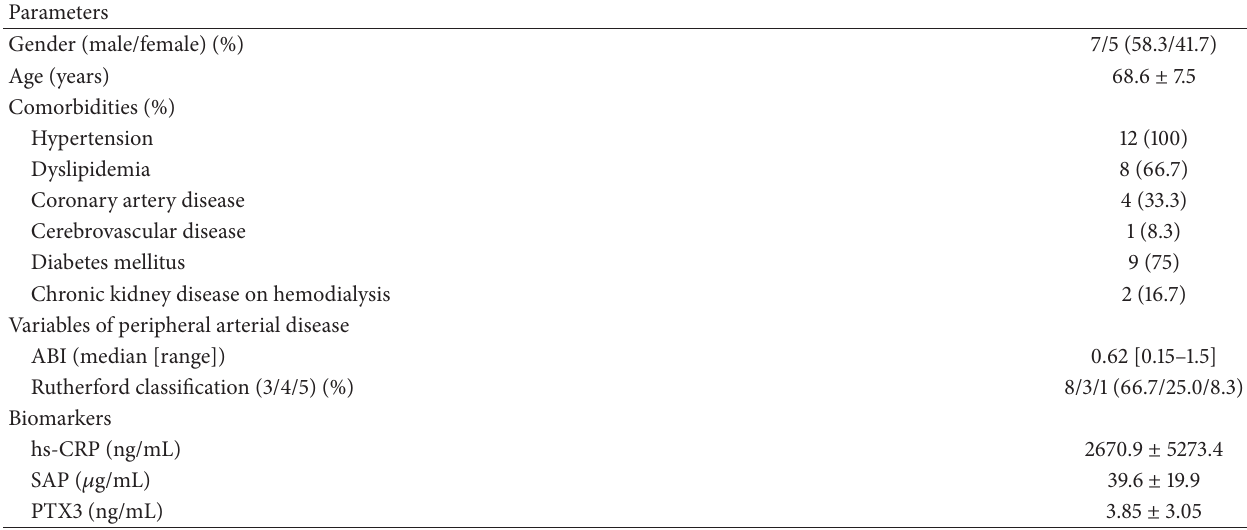
Table 1: Patient characteristics.